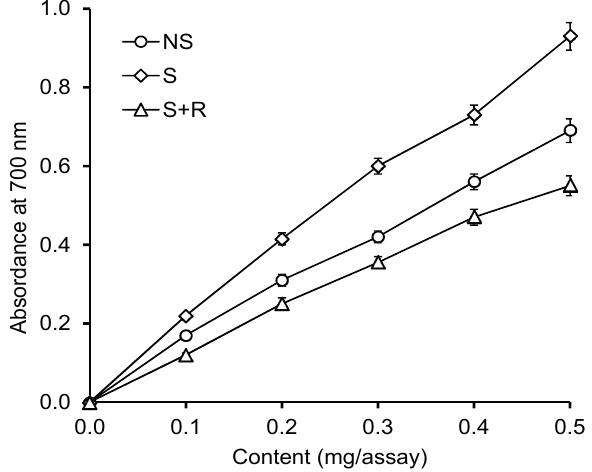
Figure 3. Reduction power of the extracts of grape